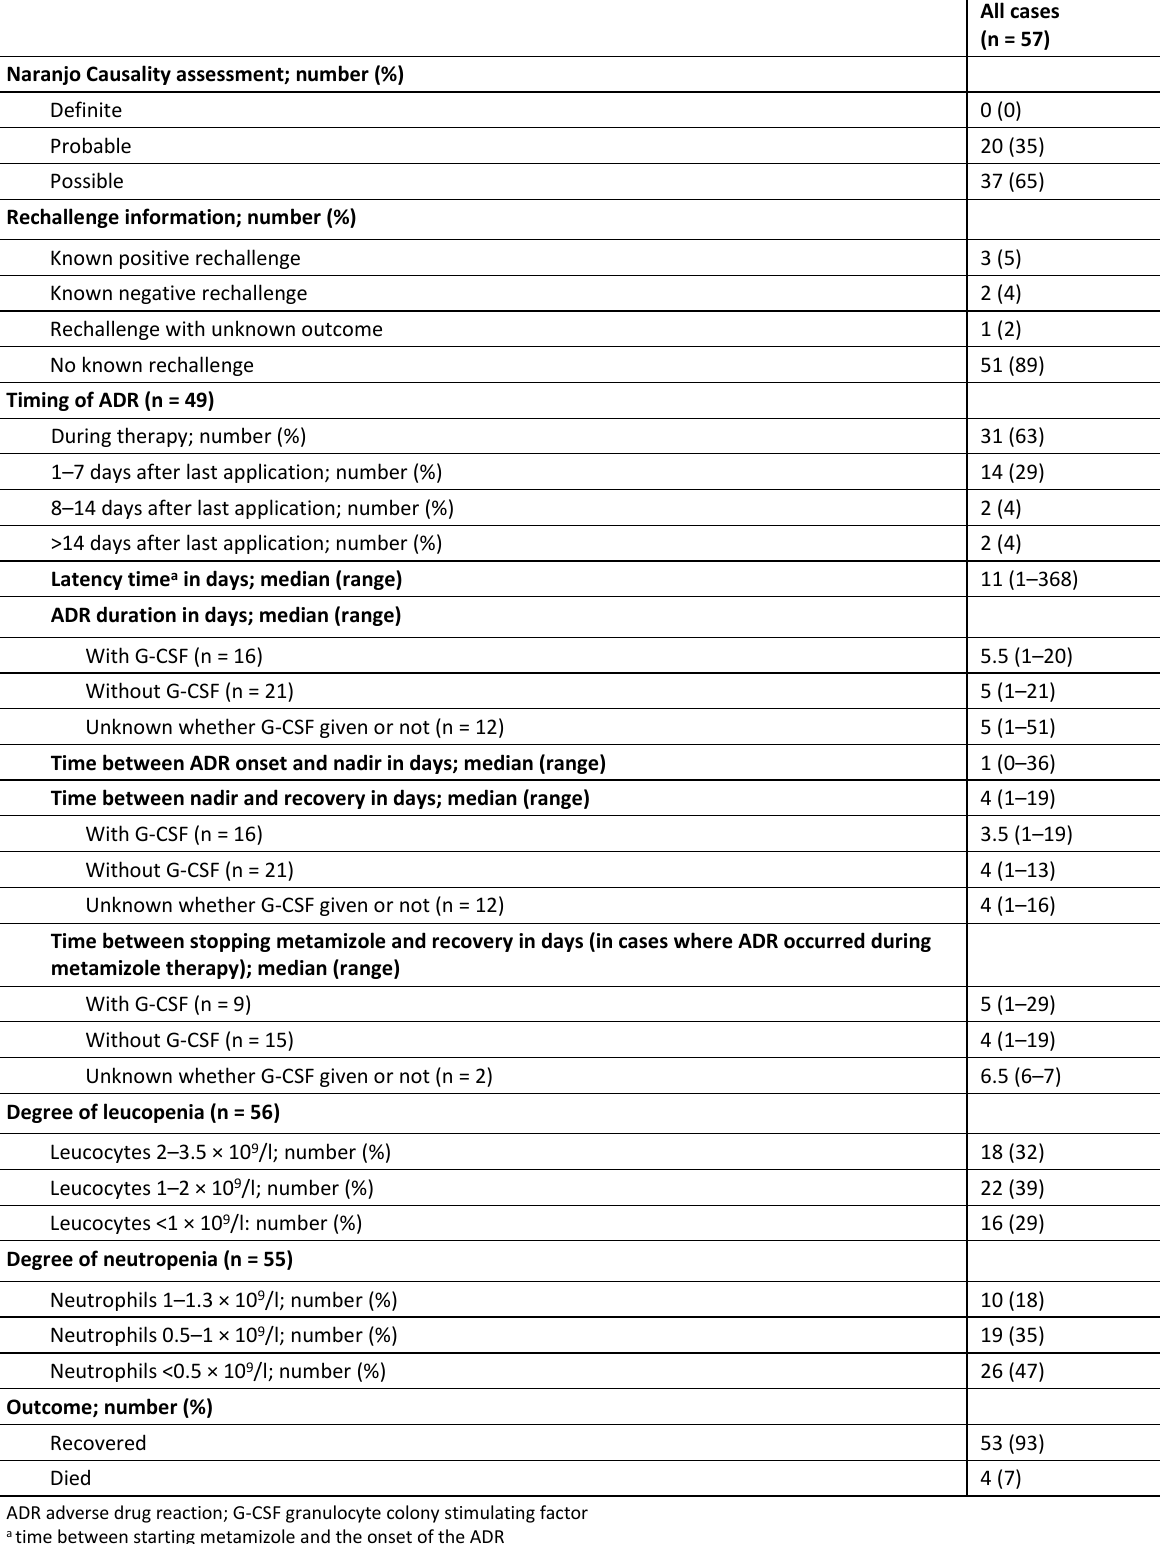
Table 3: Characteristics of the white blood cell disorders (all cases).